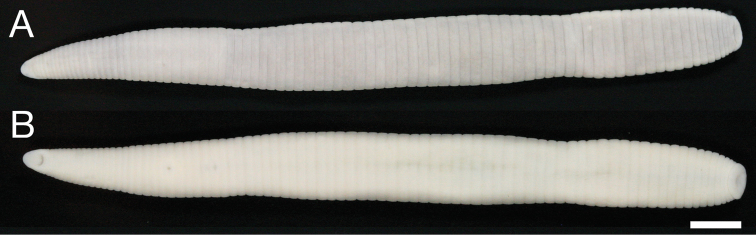
Epigynes of Singafrotypa. 6, 10
Singafrotypa acanthopus
7, 11
Singafrotypa mandela
8, 12
Singafrotypa okavango
9, 13 Singafrotypa subinermis
6–9 epigyne, dorsal 7–13, ibid., posterior (Figs 6–8, 7–12 redrawn with permission, after Kuntner and Hormiga 2002).